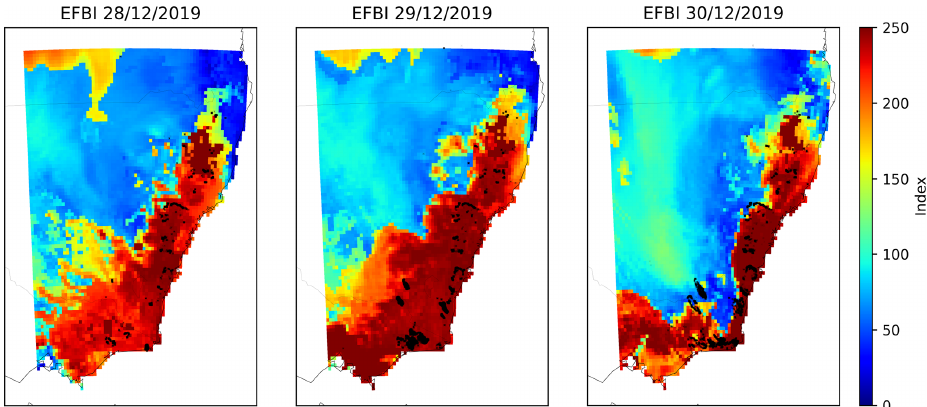
Figure 12. The EFBI from 28 to 30 December 2019 overlapped with the active fires (black dots) that took place the next day over southeastern Australia. Please note that the date format used in this figure is